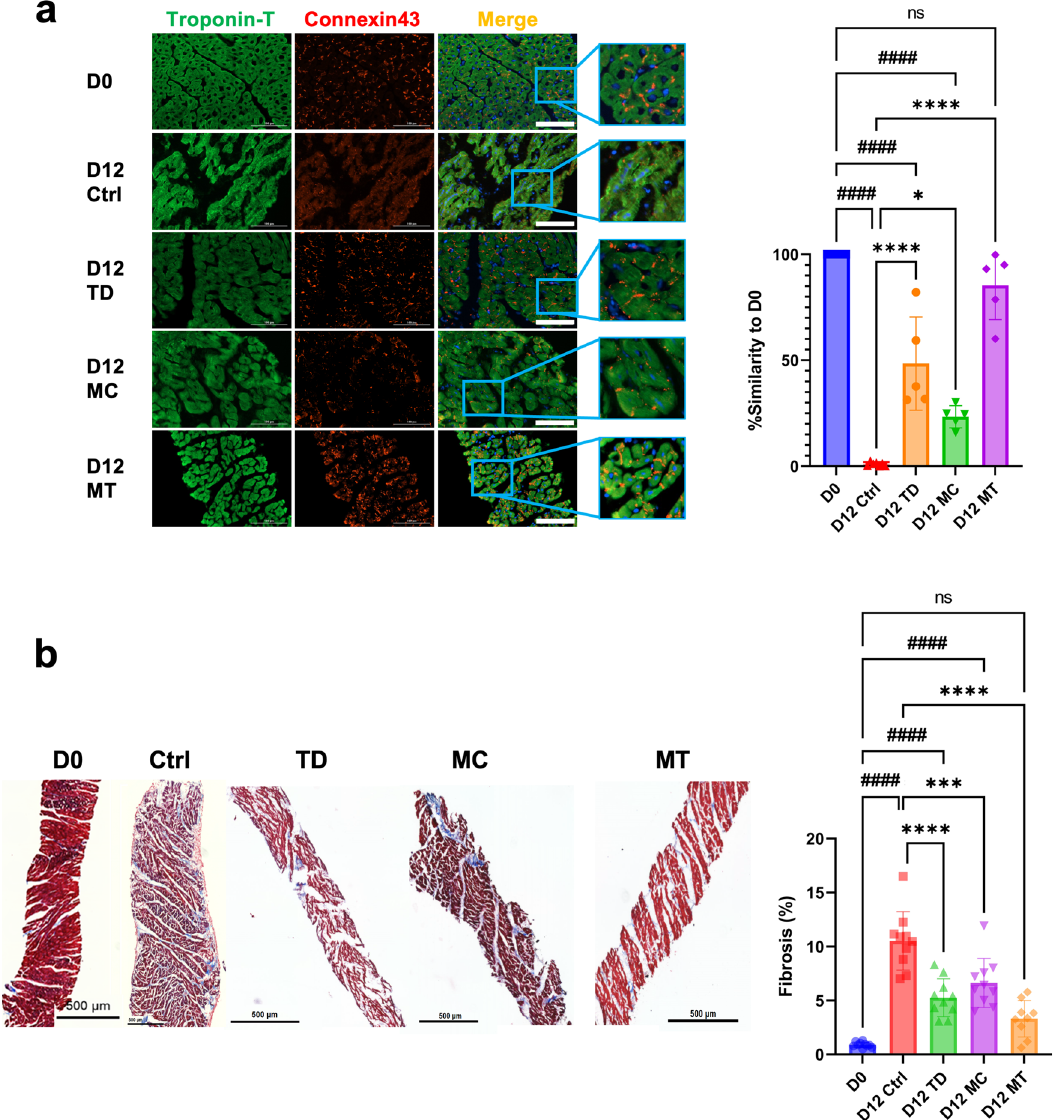
Fig. 5 Cardiac tissue structure in slices cultured for 12 days under MT conditions is similar to fresh heart slices. a Representative immuno fl uorescence images for troponin-T (green), connexin 43 (red), and DAPI (blue) for freshly isolated heart slices (D0) or heart slices cultured for 12 days under all four culture conditions (Scale bar = 100 µ m). Arti fi cial intelligence quanti fi cation of the heart tissue structural integrity ( n = 7 (D0 and D12 Ctrl), 5 (D12 TD, D12 MC and D12 MT) slices/group from different pigs, one-way ANOVA test is performed; #### p < 0.0001 compared to D0 and * p < 0.05, or **** p < 0.0001 compared to D12 Ctrl). b Representative images and quanti fi cation for heart slices stained with Masson ’ s trichrome stain